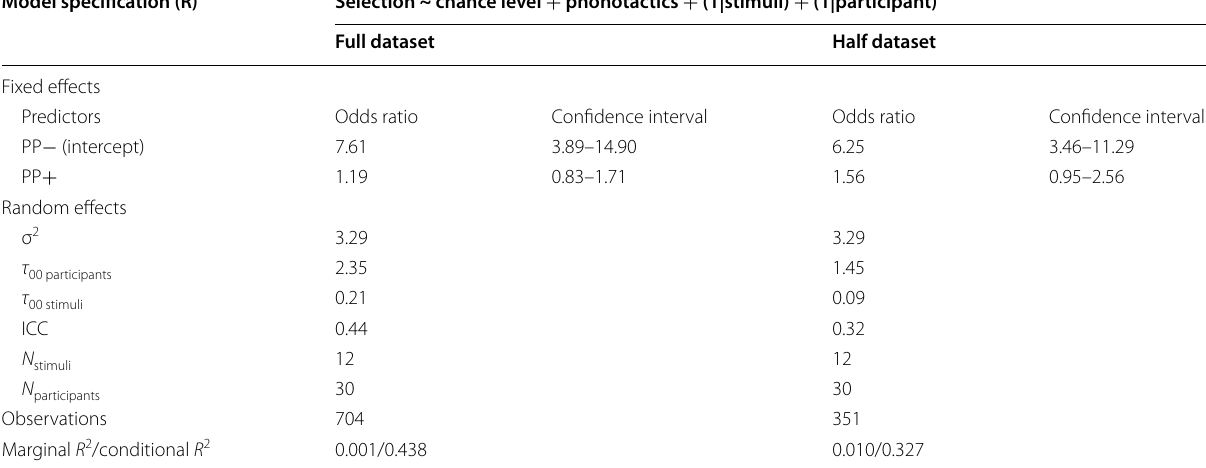
Table 2 Fixed and random effects and specifications for Frequentist models Model specification (R)